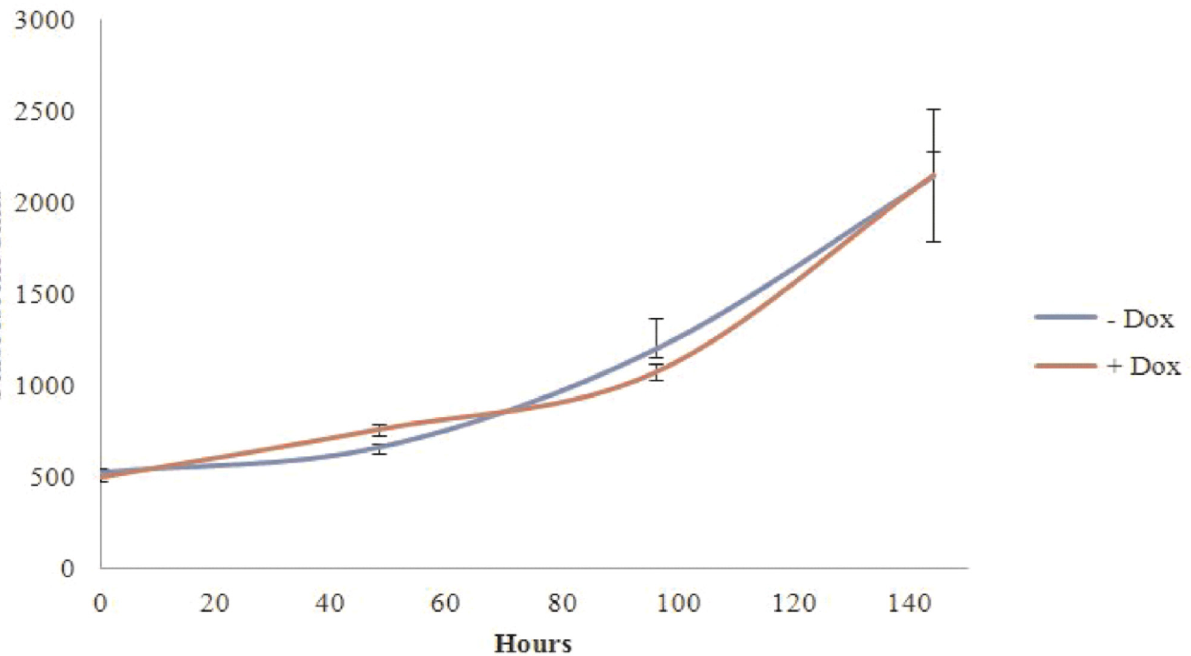
Fig 4. SBP1 does not change the proliferation of HCT116 cells. HCT116-TetSBP1 cells with (+Dox) and without (-Dox) SBP1 were grown for 6 days on a 96 well plate. Cells were treated with 1ug/mL doxycycline 48 hours before the 0 hour time point. Five hundred cells were seeded in triplicate 24 hours before the 0 hour time point. Fluorescently labeled dsDNA from each well of a 96 well plate was quantified at four time points- 0, 48, 96, and 144 hours, and error bars represent standard deviations at each time point.